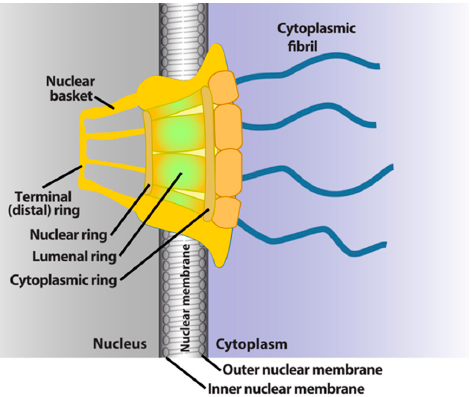
Figure 1. Schematics of the basic elements of the vertebrate nuclear pore complex. The nuclear basket, central pore, and cytoplasmic fibrils are shown. For simplicity, only four cytoplasmic fibrils and four nuclear basket protrusions are shown, rather than all eight.